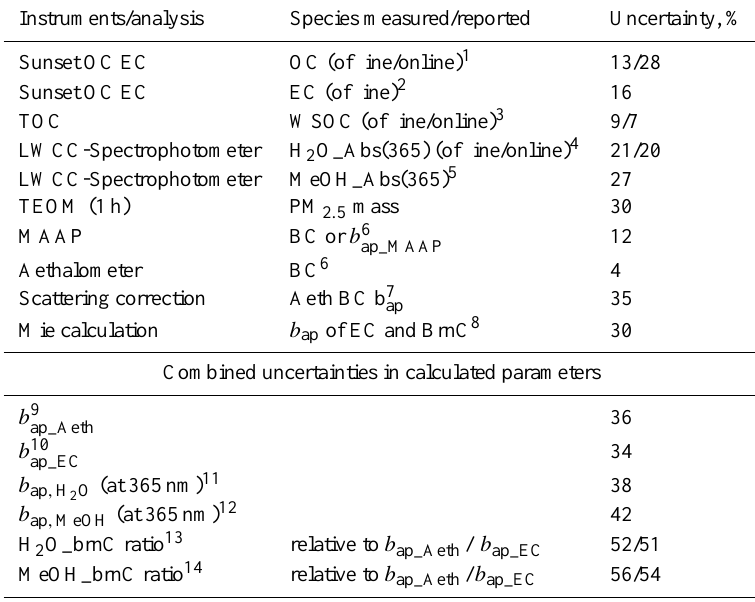
Table 2. Summary of estimated uncertainties for various species reported. In all cases where variability was used to estimate an uncertainty, 1 standard deviation is